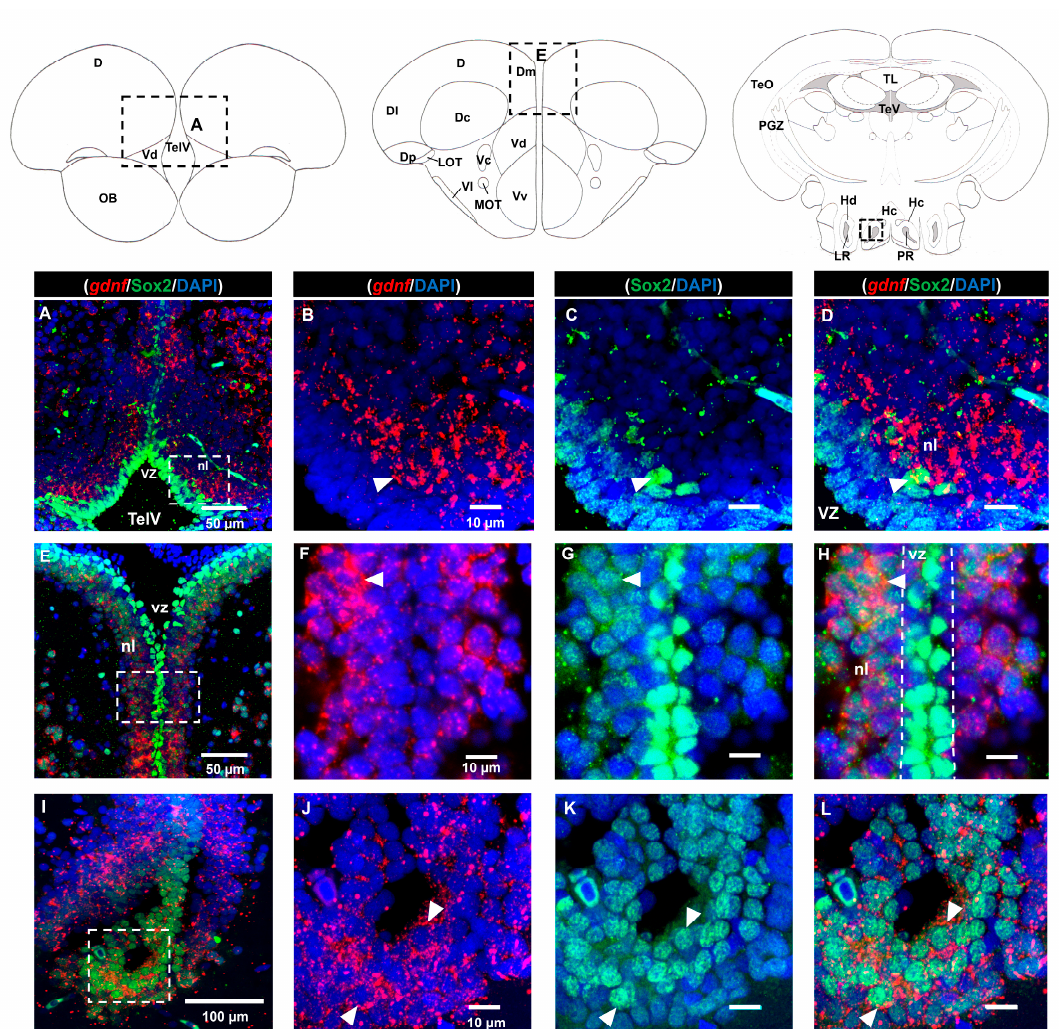
Figure 3. Co-localization of gdnf with Sox2. gdnf transcripts are found in Sox2-positive cells in the neuronal layer (nl) of ( A – D ) the dorsal nucleus of the ventral telencephalic area (Vd), ( E – H ) nl along the ventricular zone (vz)of the telencephalon and ( I – L ) the caudal zone of the periventricular hypothalamus (Hc). Black dashes in the graphical illustrations outline the regions of interest. White dashes outline the respective magnified regions that were constructed from the selected z-stacks. The white arrowheads indicate co-expression of gdnf with Sox2 immunoreactive cells. Abbreviations: D: Dorsal telencephalic area; Dc: Central zoneof dorsal telencephalic area; DI: later zoneof dorsaltelencephalic area; Dm: Medial zone of dorsal telencephalic area; Dp: Posterior zone of dorsal telencephalic area; Hc: Caudal zone of periventricular hypothalamus; Hd: Dorsal zone of periventricular hypothalamus; LOT: Lateral olfactory tract; LR: Lateral recess of diencephalic ventricle; MOT: Medial olfactory tract; nl: neuronal layer; OB: Olfactory bulb; PGZ: Periventricular gray zone of optic tectum; PR: posterior recess of diencephalic ventricle; TelV: Telencephalic ventricle; TeO: Tectum opticum; TeV: Tectal ventricle; TL: Torus longitudinalis; Vc: Central nucleus of ventral telencephalic area; Vd: Dorsal nucleus of ventral telencephalic area; VI: Lateral nucleus of ventral telencephalic area; Vv: Ventral nucleus of ventral telencephalic area; vz: ventricular